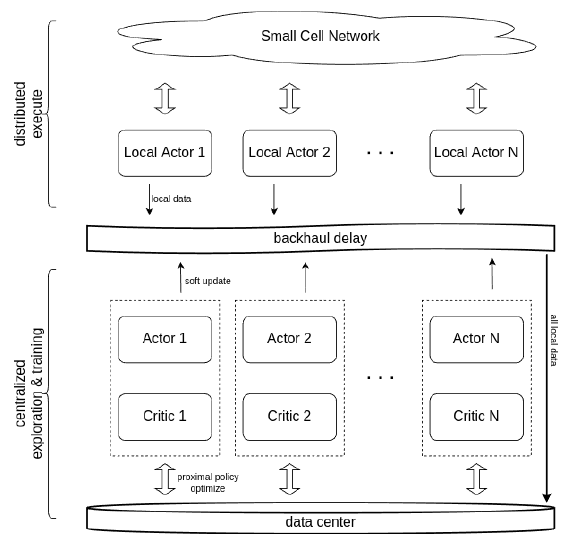
Figure 2. Policy optimization of the power allocation (POPA) algorithm